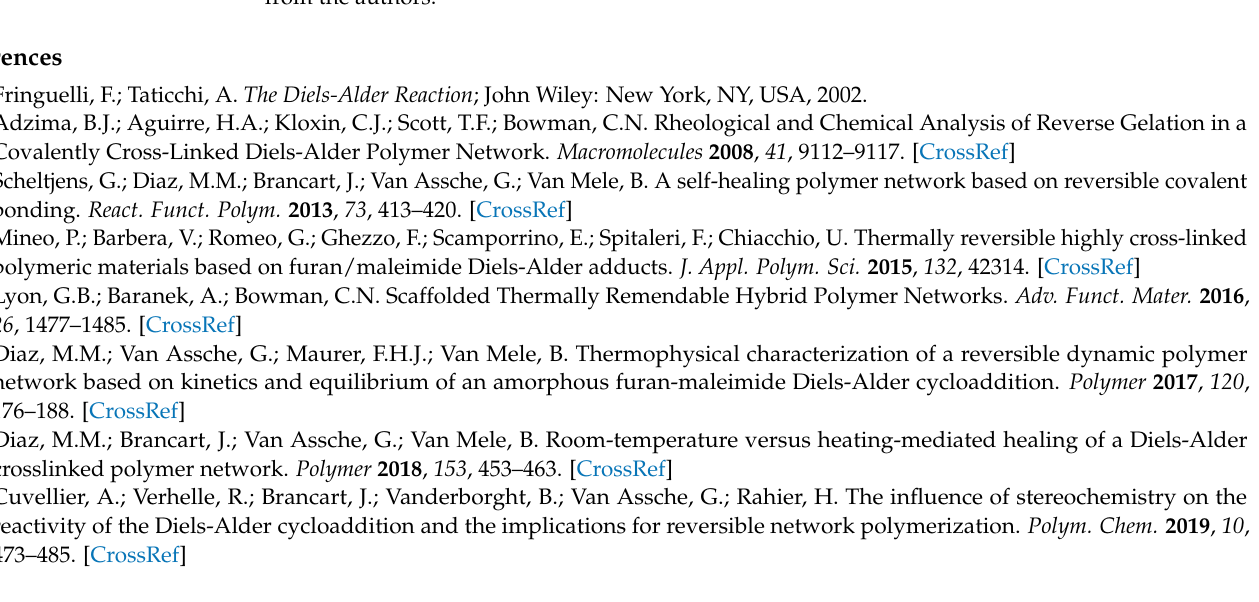
energies of furan and maleimide and their complexes with glycol (Table S5), Visualization of the high- est occupied orbitals (Figure S3), Energetics of the Diels–Alder reactions at 0 K (Table S6) and 298.15 K (Table S7), Energetics of the endo Diels–Alder reactions at 0 K with addition of 2-methoxyethanol (Table S8), Transition state structures for the uncoordinated and hydrogen bond-assisted reactions (Figure S4), Energetics of the Diels–Alder reactions between Maleimide and OH-free furan (Table S9), Computed kinetics of the Diels–Alder reactions between Maleimide and Furan (Table S10), Computed kinetics of the Diels–Alder reactions between Maleimide and OH-free furan (Table S11), Experimental versus computed Diels–Alder rate constants k DA at 20 ◦ C (Table S12), Cartesian